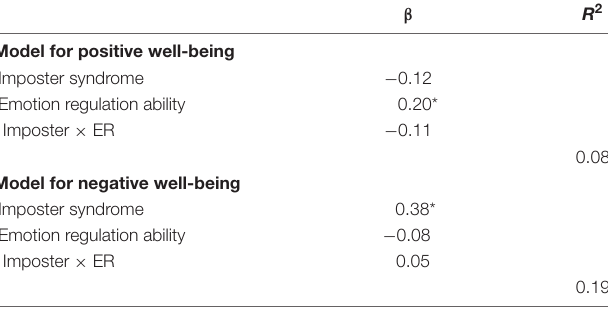
TABLE 4 | Regression coefficients in predicting well-being using imposter syndrome and